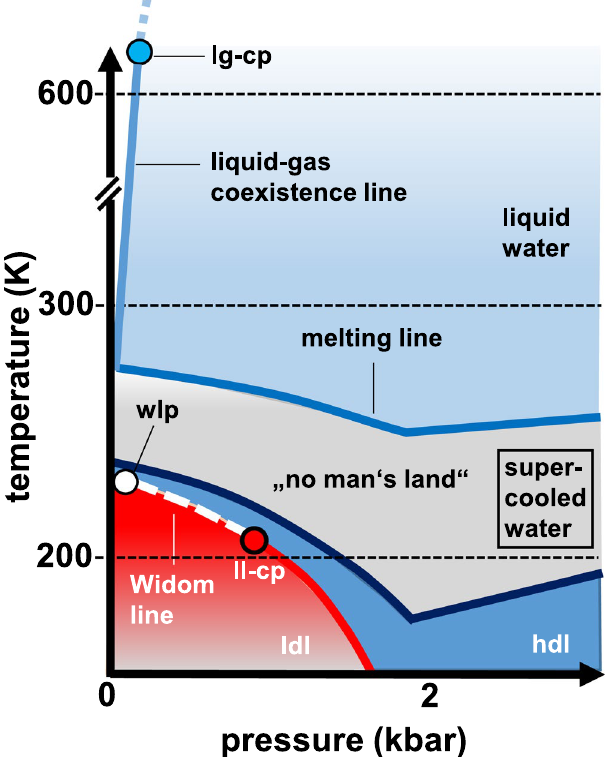
Figure 1. Temperature versus pressure phase diagram of water, lg-cp refers to liquid-gas critical point, wlp is the Widom line point and ll-cp indicates the liquid-liquid critical point, which is the focus of the present work. We have used in our analysis  T 180 K , see main text. Picture after 2,6 c